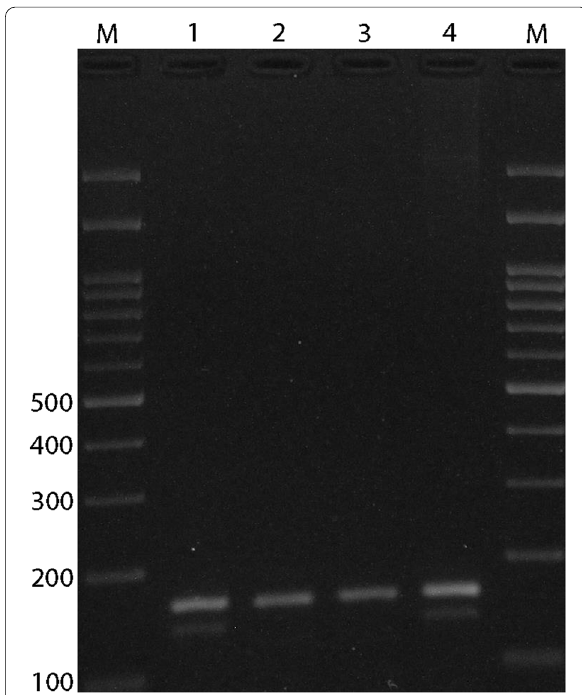
Fig. 2 Electrophoresis pattern of the PCR-RFLP products for AGT rs699 polymorphism detection. M: DNA marker; Lanes 1, 4: TC; Lanes